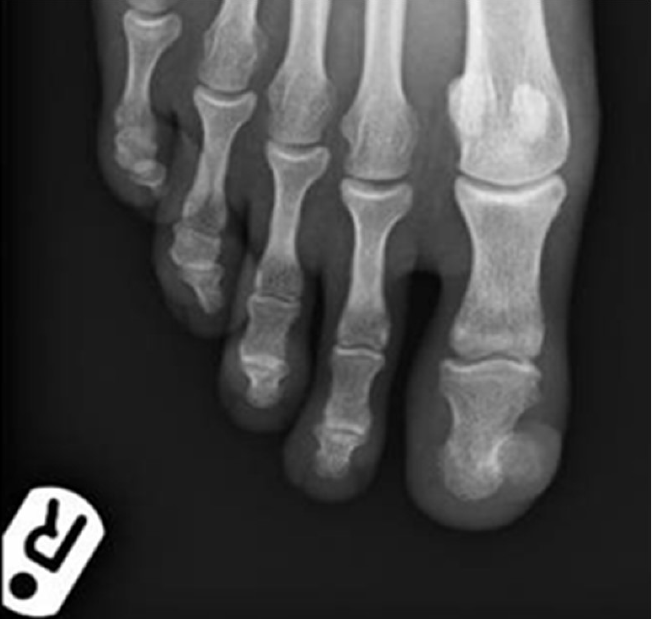
Figure 2. Antero-posterior plain radiograph of the right forefoot showing exostosis arising from the distal phalanx of the right big toe.